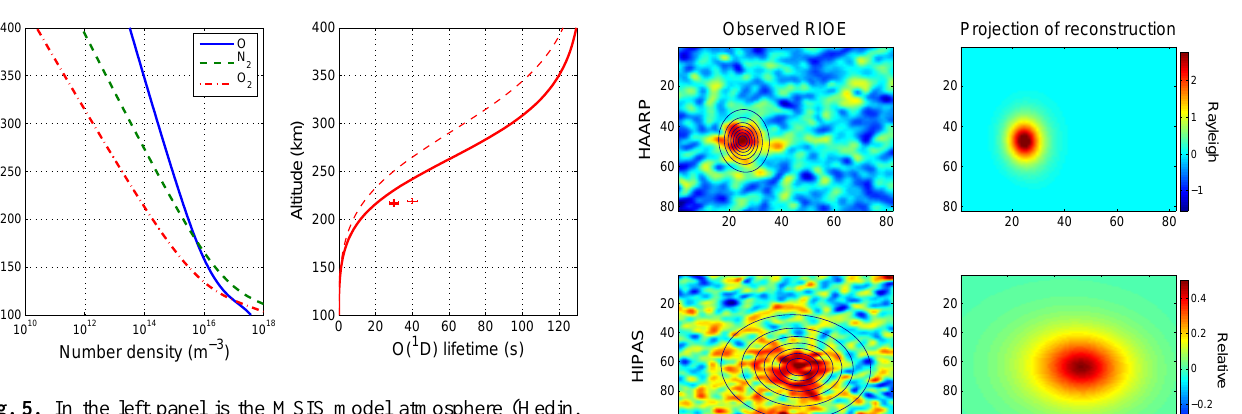
Fig. 5. In the left panel is the MSIS model atmosphere (Hedin, 1991) for HIPAS on 19 March 2007, and in the right panel is the estimate of the altitude variation of O ( 1 D ) effective life- time, calculated with the O ( 1 D ) + O ( 3 p3P ) quenching rate of 2 × 10 − 18 cm 3 s − 1 from Solomon et al. (1988) (thick solid curve) and with the 22 × 10 − 18 cm 3 s − 1 from Closser et al. (2005) (thin dashed curve). The red points with horizontal and vertical error bars mark the O ( 1 D ) lifetime estimated from the decay of the HIPAS observations at 6300 at the altitude of the emission, as discussed in Sect. 4.